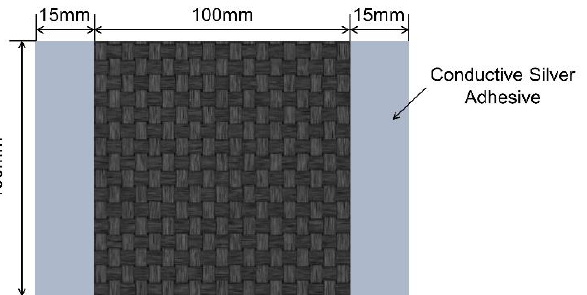
Figure 1. Geometric dimension of carbon fiber fabric sample and coating position of conductive silver adhesive.